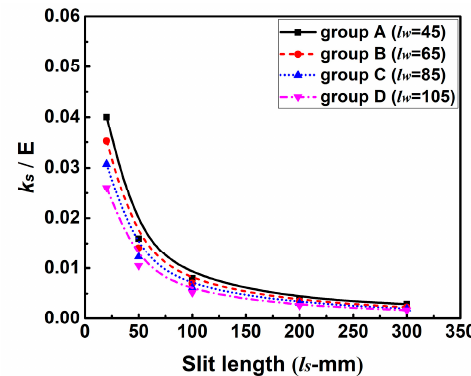
Figure 14. Influence of slit length ( l s ) on the intensity of restraint ( k s ).